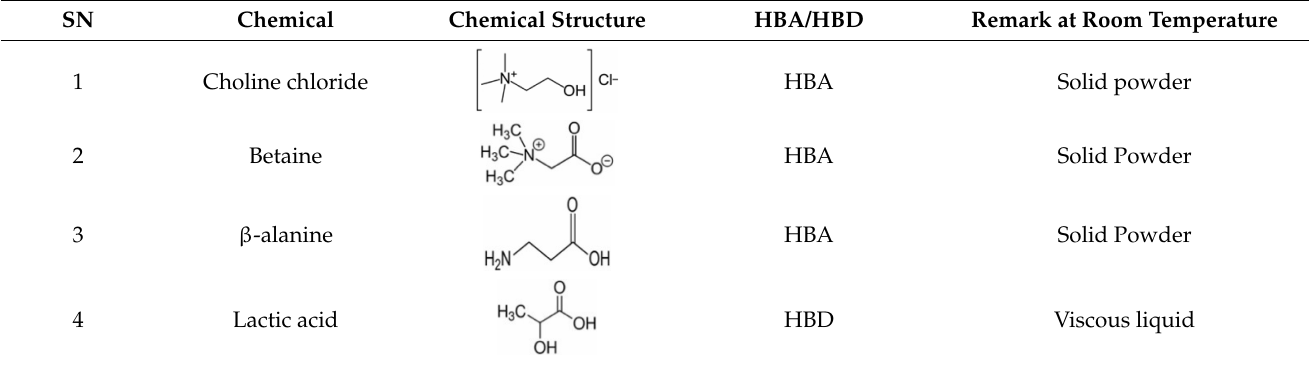
Table 1. Chemicals used in the preparation of the NADES